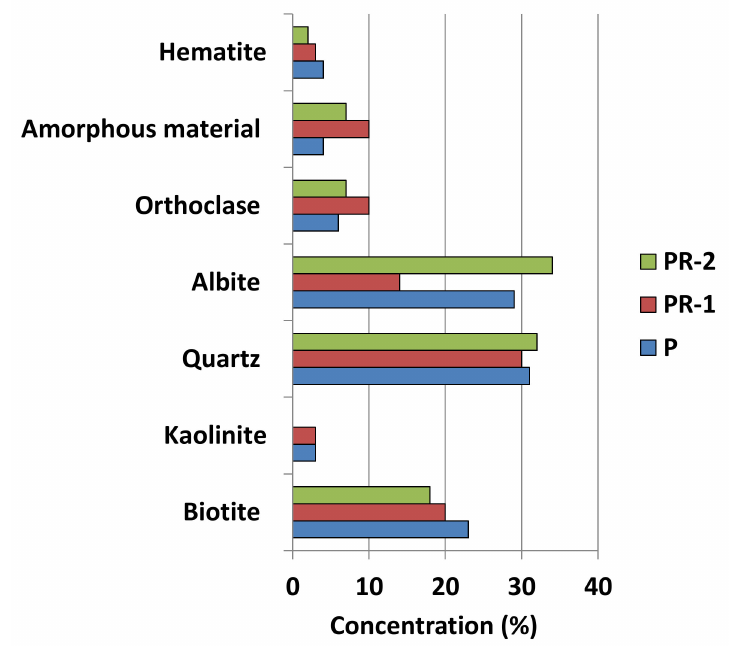
Figure 1. Minerals concentration by XRD di ff raction from natural